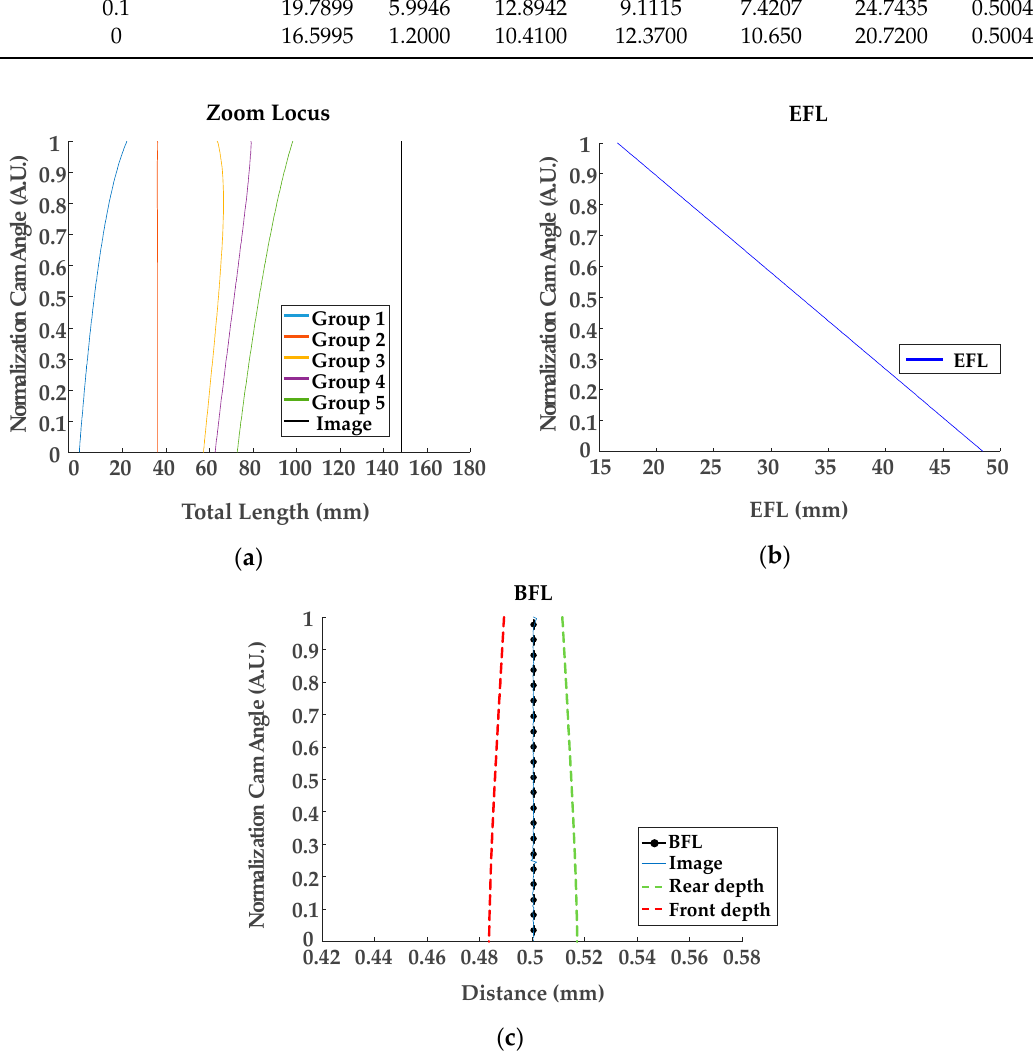
Figure 9. Results of the reapplication of the Padé approximation to results in Table 6. ( a ) Zoom locus of each lens group, ( b ) EFL of this optical system, and ( c ) error for image plane.